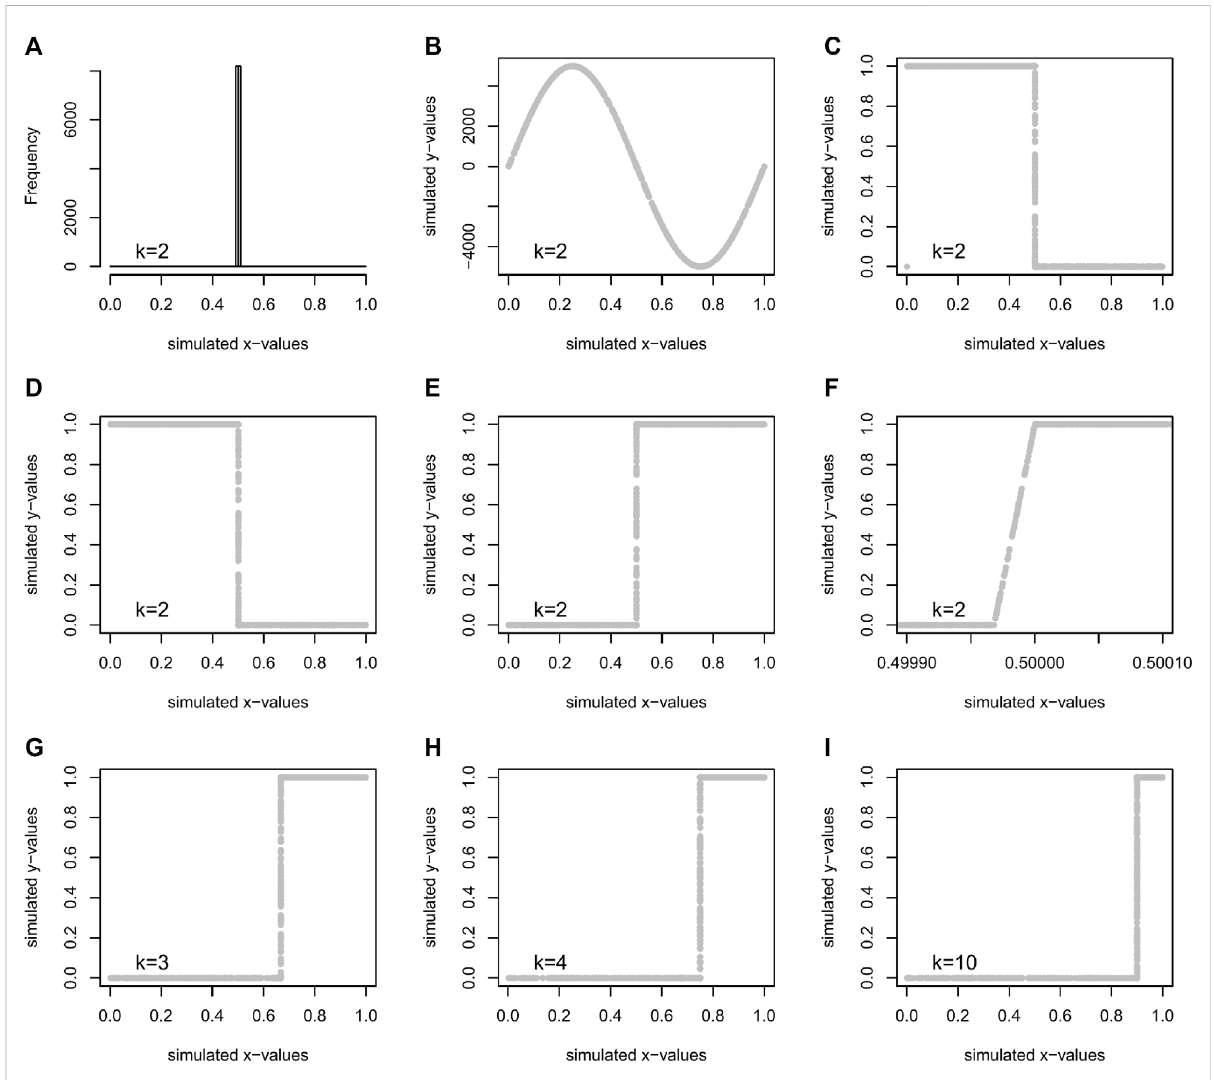
FIGURE 2 Data generated for training aCNN ( σ CNN )to approximate the hard sigmoid function with k classes. The frequency of the simulated x values(Eqs 5,6)fork=2 (A) ,simulatedsinfunctionfromthesimulatedxvalueswithEq.7 (B) ,clippedvaluesontherange[0,1]Eq.8 (C) ,yvaluedifferentof1setto 1 for x value near 09 (D) , inversionalong x for even k classes, Eq. 10, and y valuedifferent of1 are set to 1 for x valuenear 1,Eq. 11, to obtain the fi nal y valueusedtotrainthemodelforanumberofclasses k =2 (E) ,detailsofthelinearpartwhereyrisefrom0to1 (F) ,examplesofdatasimulatedto train the model for a number of k classes of 3 (G) , 4 (H) and 10 (I)